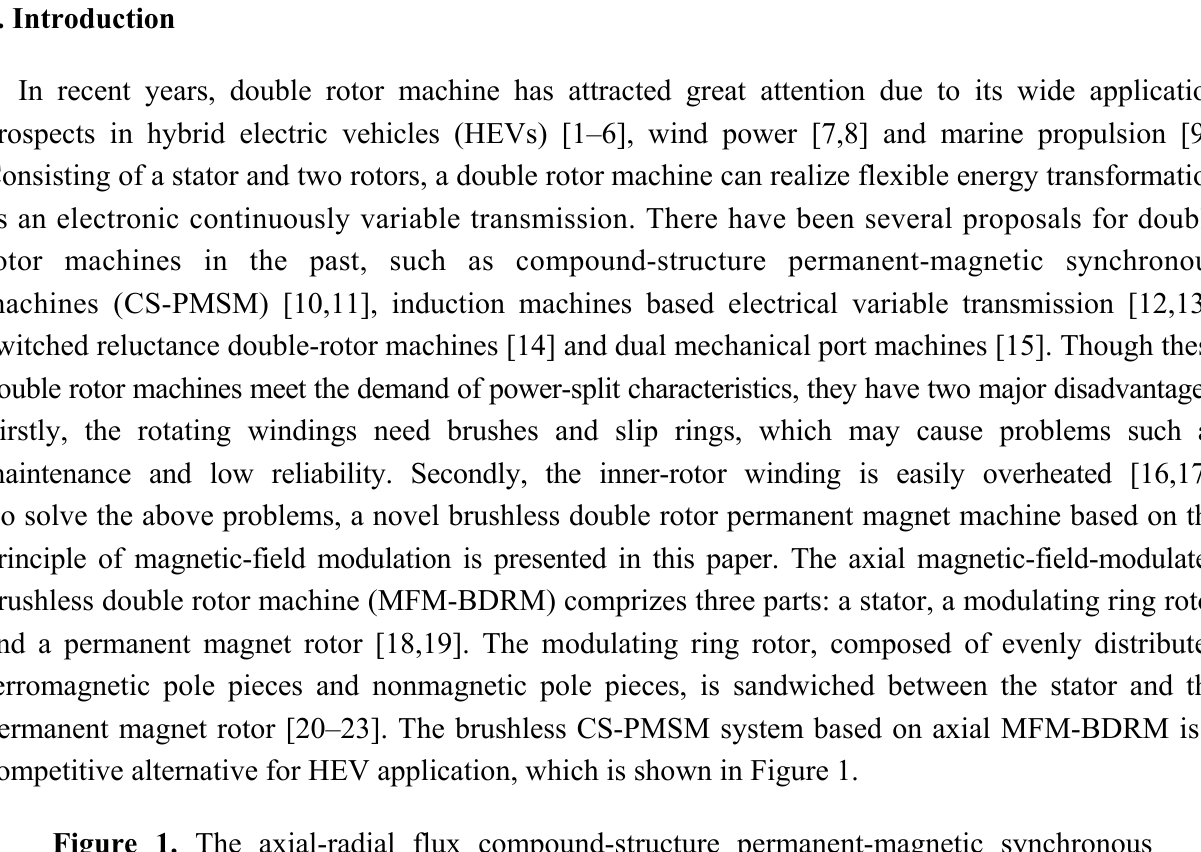
Figure 1. The axial-radial flux compound-structure permanent-magnetic synchronous machine (CS-PMSM)